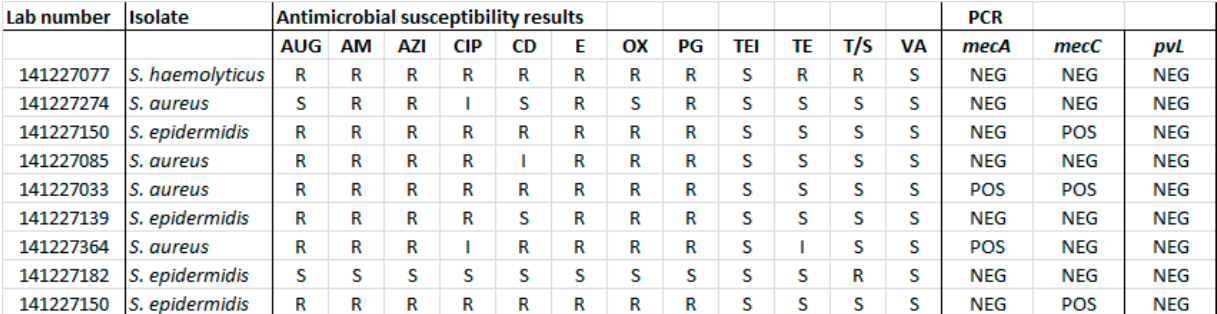
Figure 3. Demonstration of effect of bovine lactoferrin (bLF) on Extended spectrum β -lactamase producing clinical Escherichia coli.